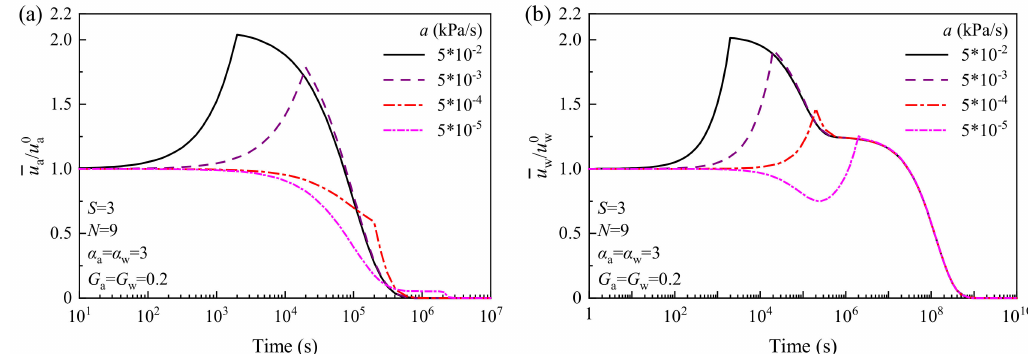
Figure 3. Dissipation of ( a ) excess pore-air and ( b ) pore-water pressures against various ramp loading parameters, a .